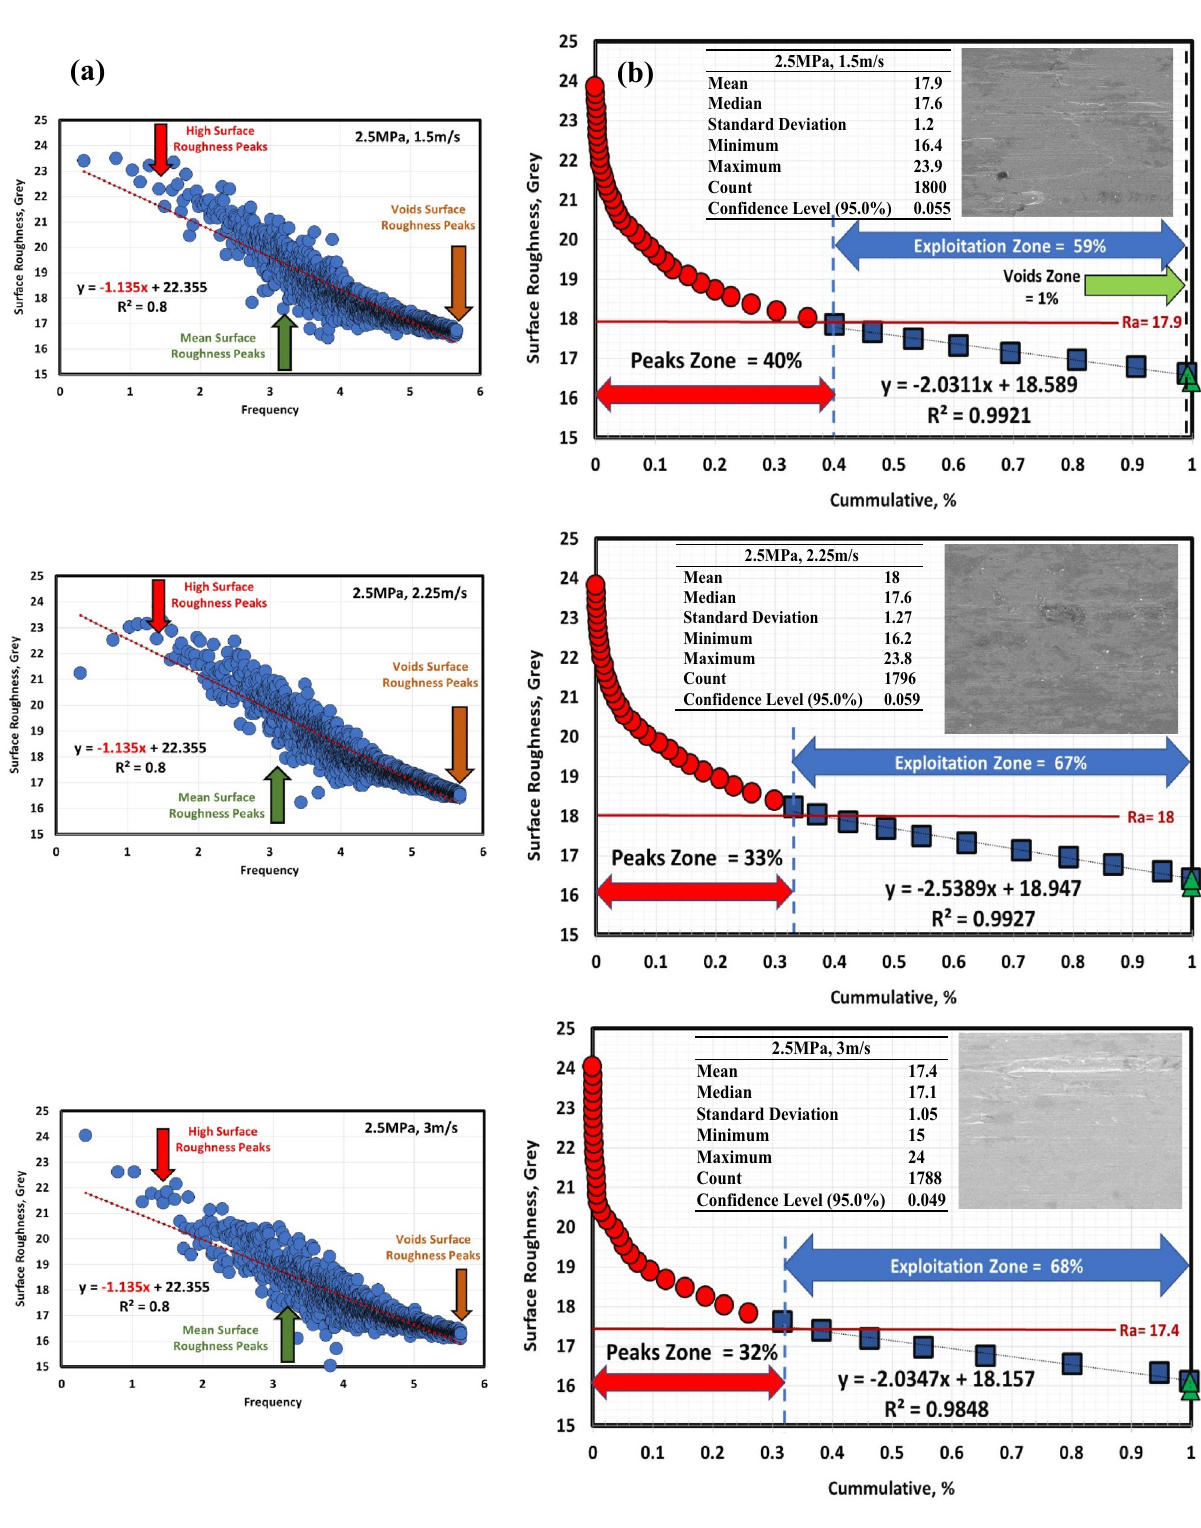
Figure 11. ( a ) Surface texture and ( b ) Abbott Firestone curves at 2.5 MPa and different velocities of QAM f